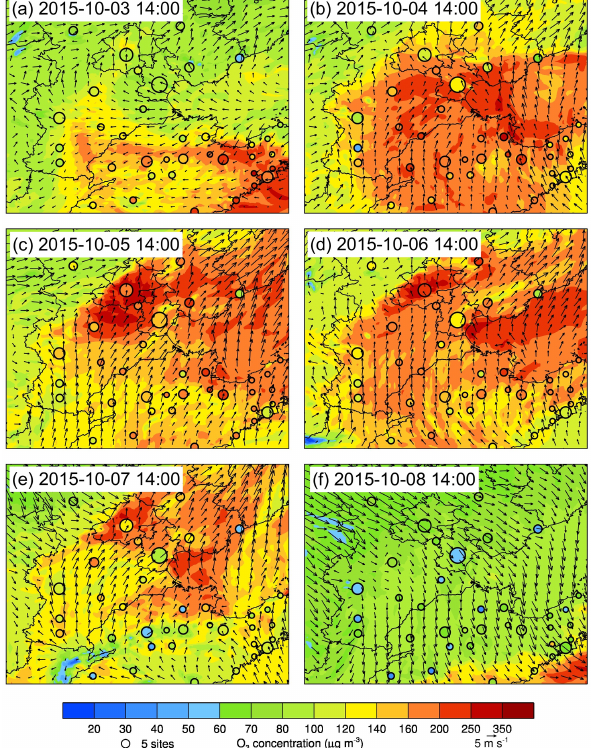
Figure 7. Spatial distributions of the modeled (colored shadings) and observed (colored dots) surface O 3 concentration at 14:00 (lo- cal time) from 3 to 8 October 2015. Black arrows show the simu- lated surface